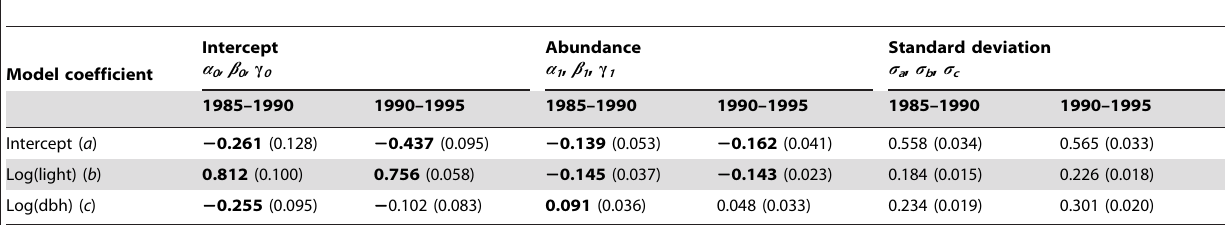
Table 1. Parameters of the species-level model of tree growth. Means (s.d.) of parameter estimates from the species-level model. Coefficient estimates that are significantly different from zero (based on 95% credible intervals) are highlighted in